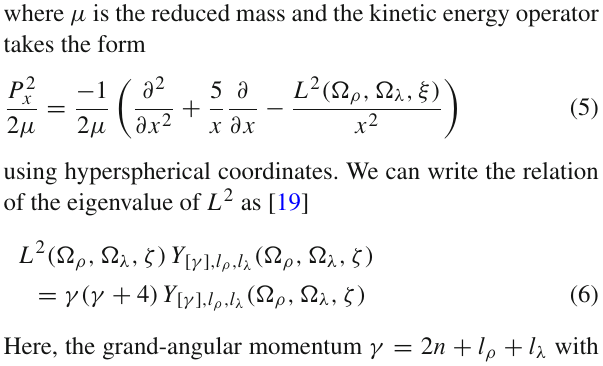
α 2 + 5 c F n f + s x x 18 π + 0 . 03 x − 4 α s + 3 x 3 x